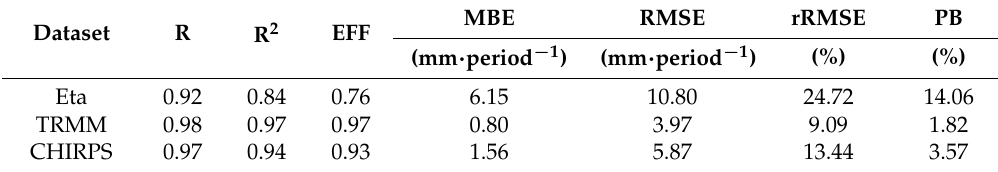
Table 7. Coefficients of correlation (R), determination (R 2 ) and Nash-Sutcliffe efficiency (EFF), average of errors (MBE), root mean squared error (RMSE), relative root mean squared error (rRMSE), and